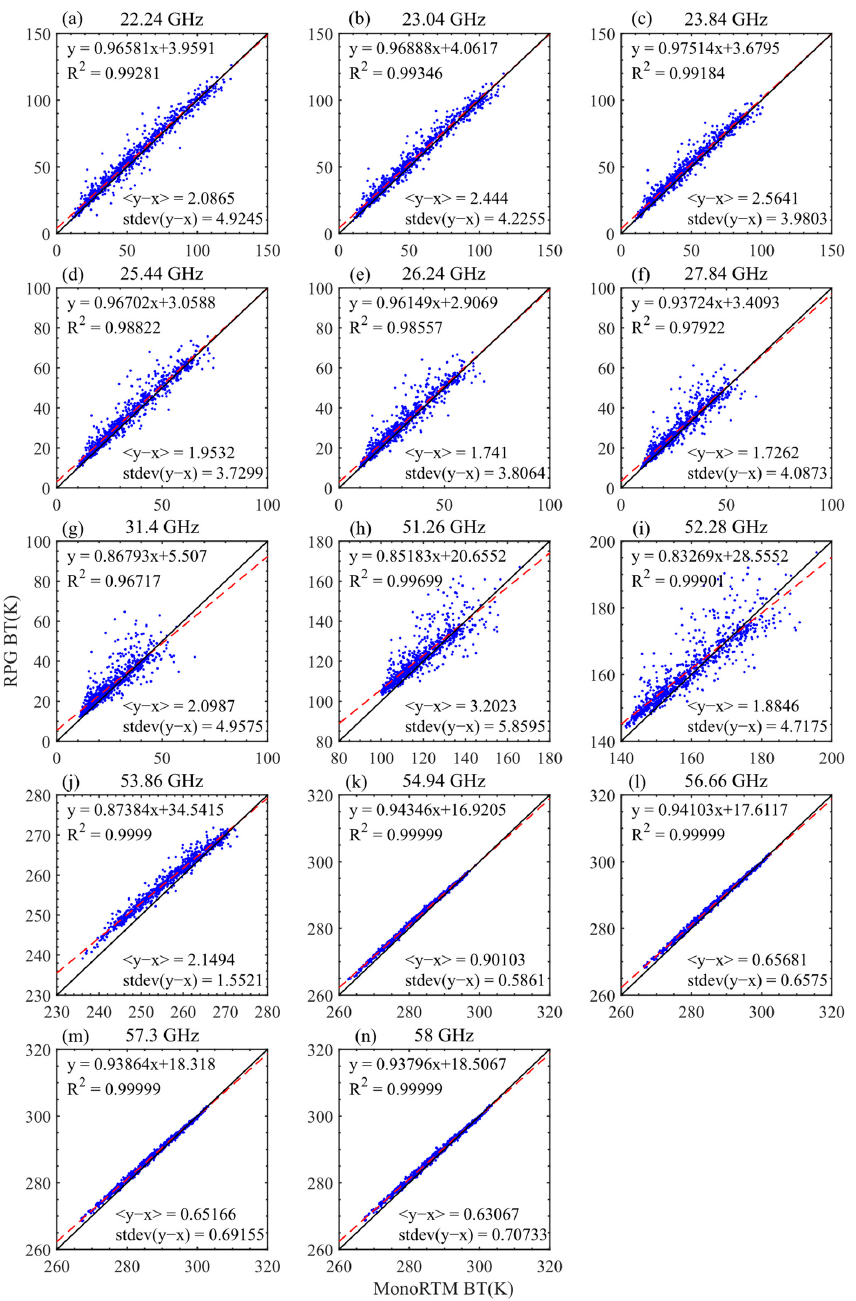
Figure 7. Scatter diagrams of observed BTs and simulated BTs (with CLW) in the no-precipitating cloudy weather (the red dashed lines are fitting straight lines). ( a ) 22.24 GHz, ( b ) 23.04 GHz, ( c ) 23.84 GHz, ( d ) 25.44 GHz, ( e ) 26.24 GHz, ( f ) 27.84 GHz, ( g ) 31.40 GHz, ( h ) 51.26 GHz, ( i ) 52.28 GHz, ( j ) 53.86 GHz, ( k ) 54.94 GHz, ( l ) 56.66 GHz, ( m ) 57.30 GHz, and ( n ) 58.00 GHz.